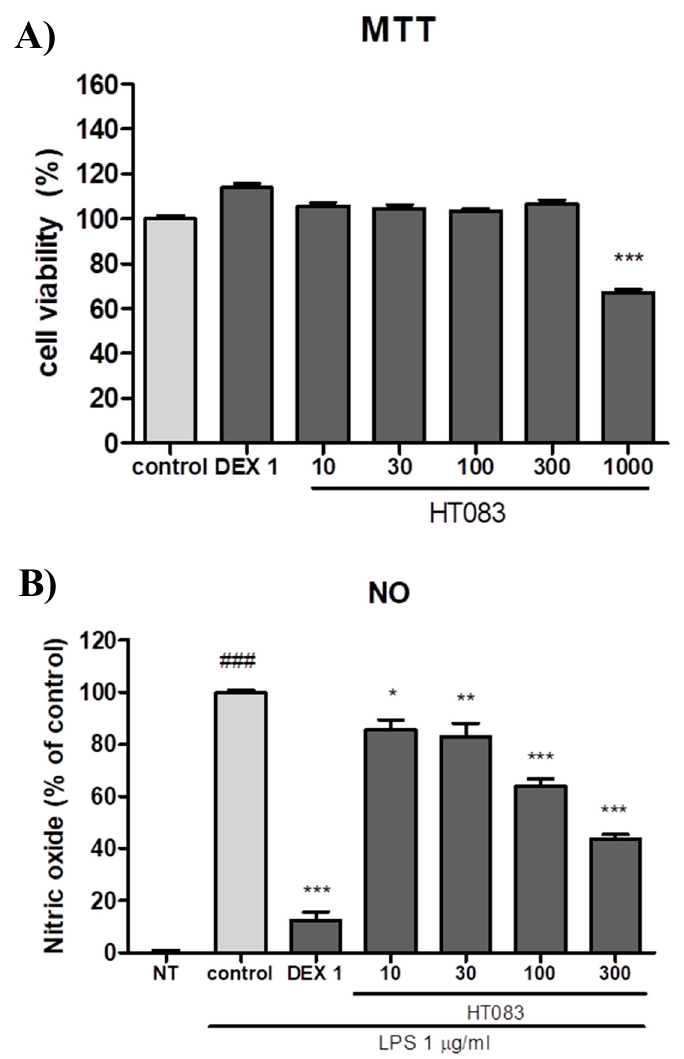
Figure 6. Effects of HT083 on cell viability ( A ) and NO production ( B ) in lipopolysaccharide (LPS)-stimulated RAW 264.7 cells. Cells were pretreated with 10, 30, 100, and 300 µ g / mL of HT083. Each value is the mean ± SEM. * p < 0.05, ** p < 0.01 and *** p < 0.001 vs. control; ### p < 0.001 vs. no treatment (NT) (one-way ANOVA, Dunnett’s post hoc test). MTT; thiazolyl blue tetrazolium bromide, NO; nitric